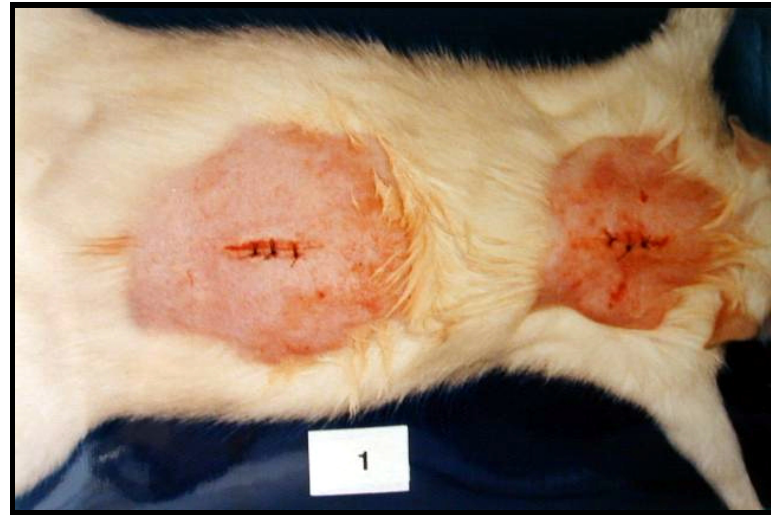
FIGURE 3 – Photograph of rat, showing the two sutured wounds.